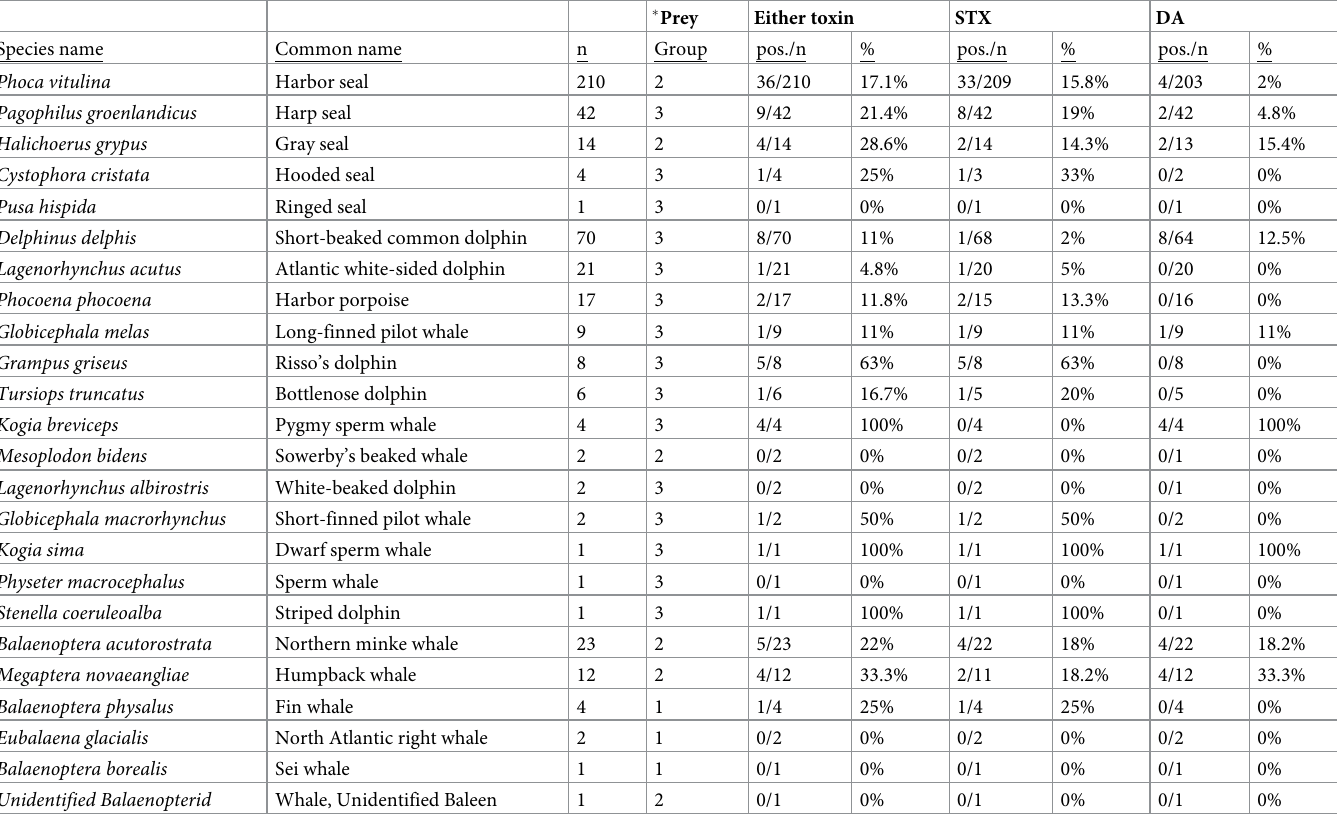
Table 5. Toxin detection frequencies by